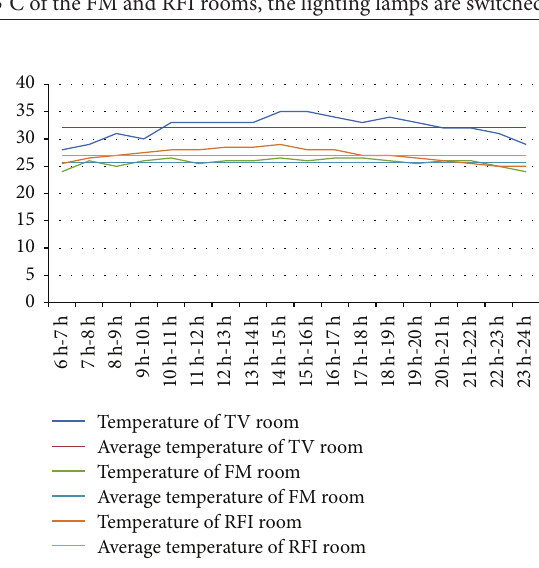
Figure 10: Hourly temperature curve of 05/06/2012.